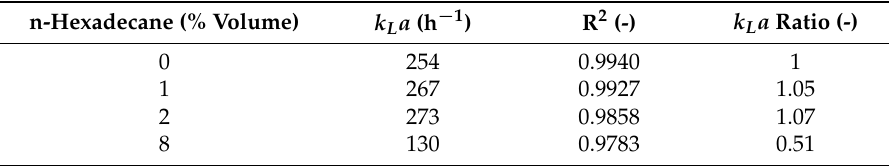
Table 1. Oxygen k L a in a mineral solution with n-hexadecane.